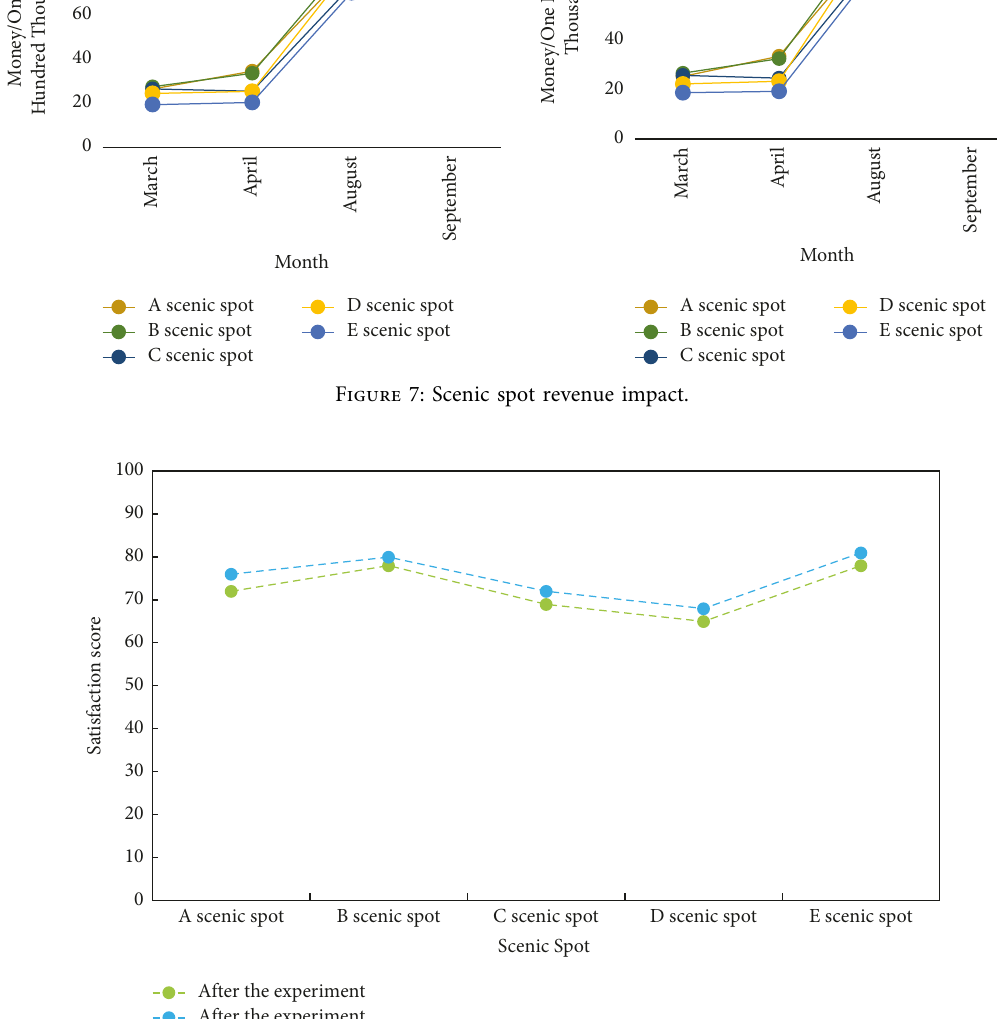
Figure 8: Comparison of tourist